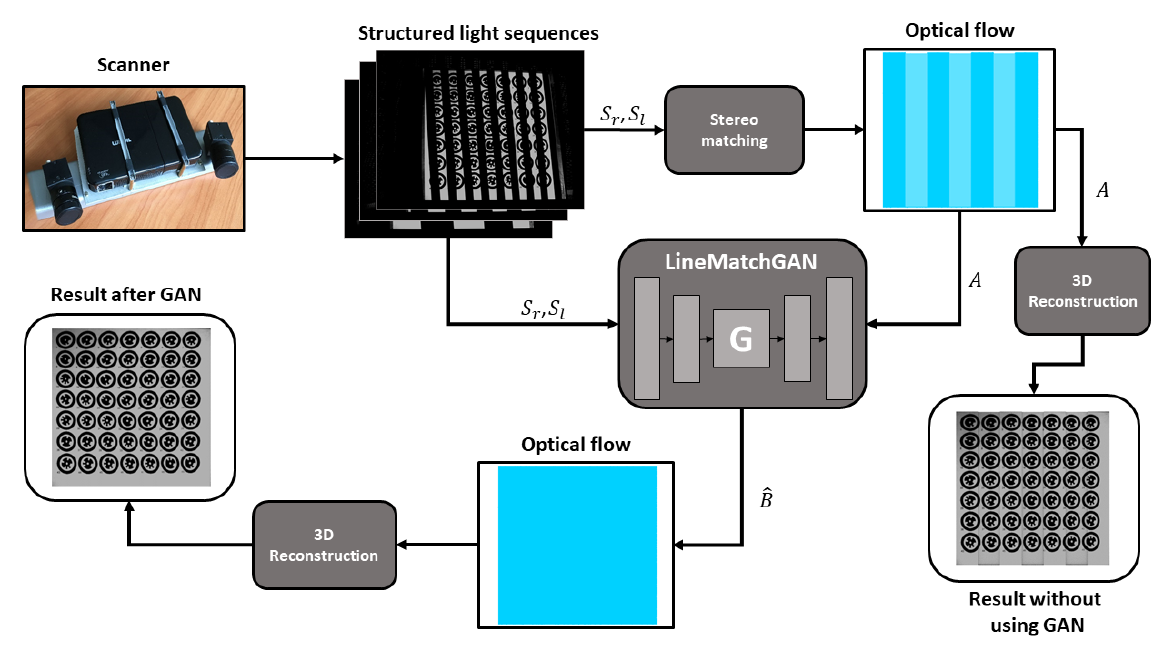
Figure 1. The pipeline of the developed